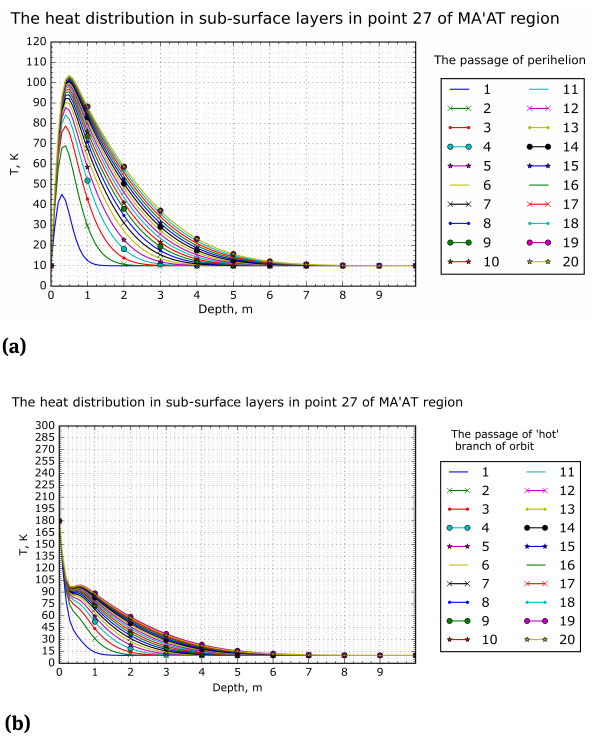
Figure 4. The depth temperature distribution in the point 27 of MA’AT region for the 20 comet orbital revolution